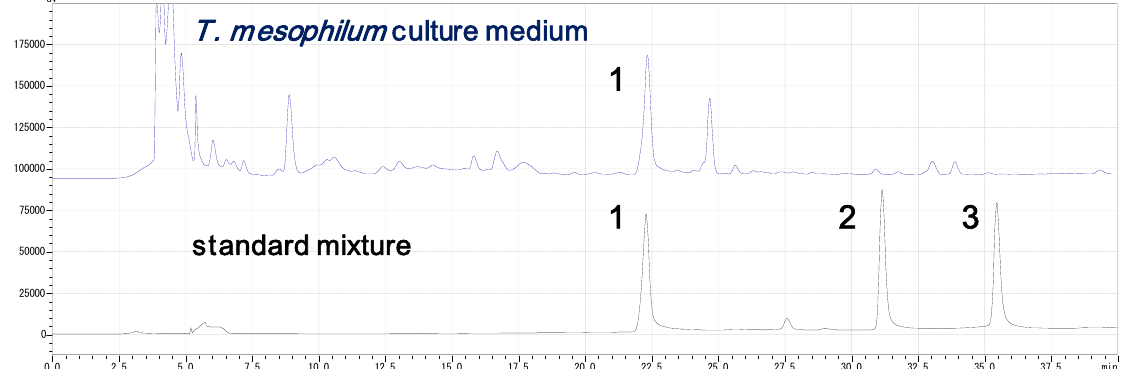
Figure 2. Reversed-phase HPLC chromatograms of T. mesophilum culture medium (upper) and a mixture of compounds 1 – 3 (lower). Centrifuged cultured medium was injected directly onto the column without any prior fractionation or concentration steps. The identity of bisucaberin B ( 1 ) in both samples was confirmed by co-injection. Fractions were collected every 2 min. The siderophore activity was found only in the fraction containing peak 1 in the upper